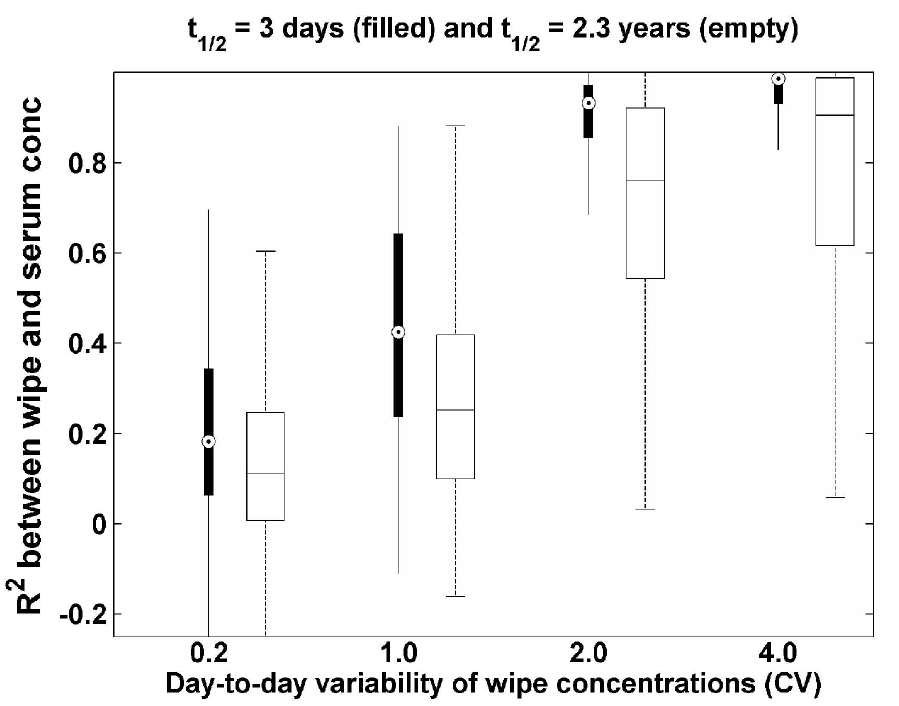
Figure 3. R 2 with different day-to-day variability of wipe concentrations for two compounds with 3 days of half-life (filled) and 2.3 years of half-life (empty).